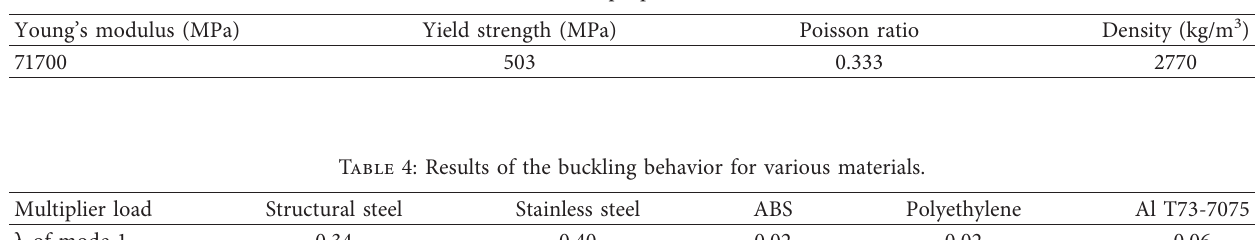
Figure 6: Physical model and deformation of the TLET joint: (a) prototype, (b) deformation in the x -axis, (c) deformation in the z -axis. Table 3: Mechanical properties of Al T73-7075.